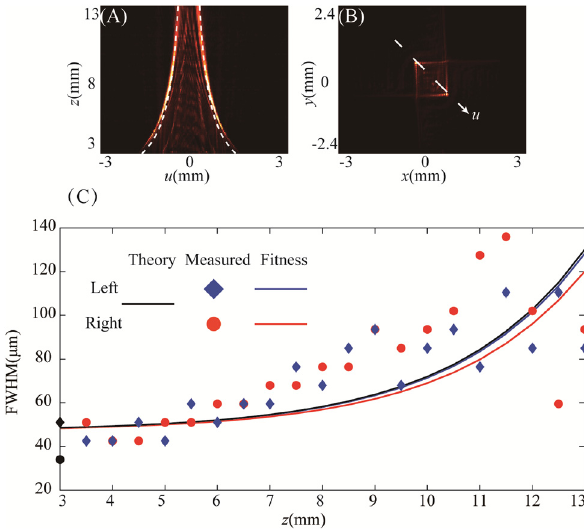
Figure 5: Measured results under linearly polarized incidence. (A) The measured self-accelerating trajectories on the u-z plane, where u is the line between the two symmetric major lobes. The white dotted lines are theoretical trajectories. (B) Measured diffraction pattern on the x - y plane at z = 7 mm. (C) The measured FWHM values of left and right ones at the wavelength of 10.6 μ m, and the blue and red curves are the fi tted curve of the measureddata. The black curve is the theoretical